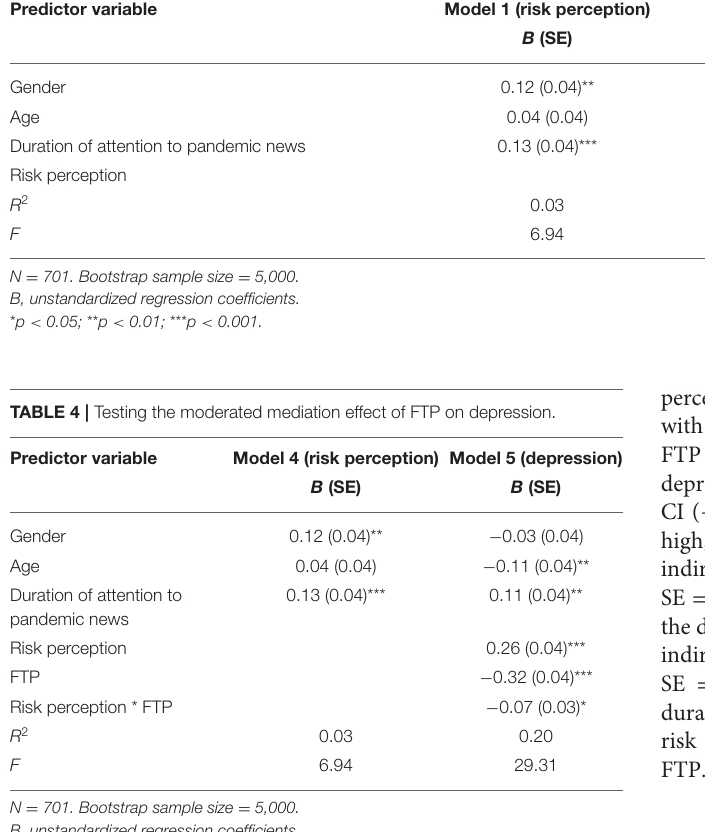
TABLE 3 | Testing the mediation effect of risk perception on depression. Predictor variable